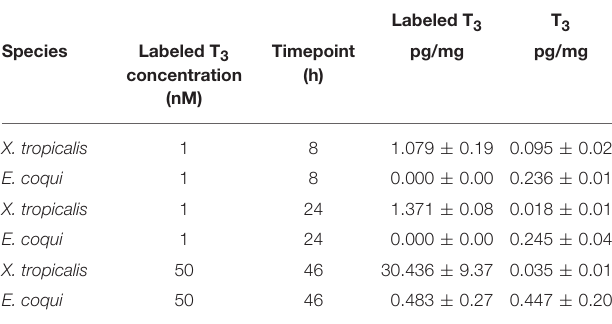
immersion in labeled T 3 for 8, 24, or